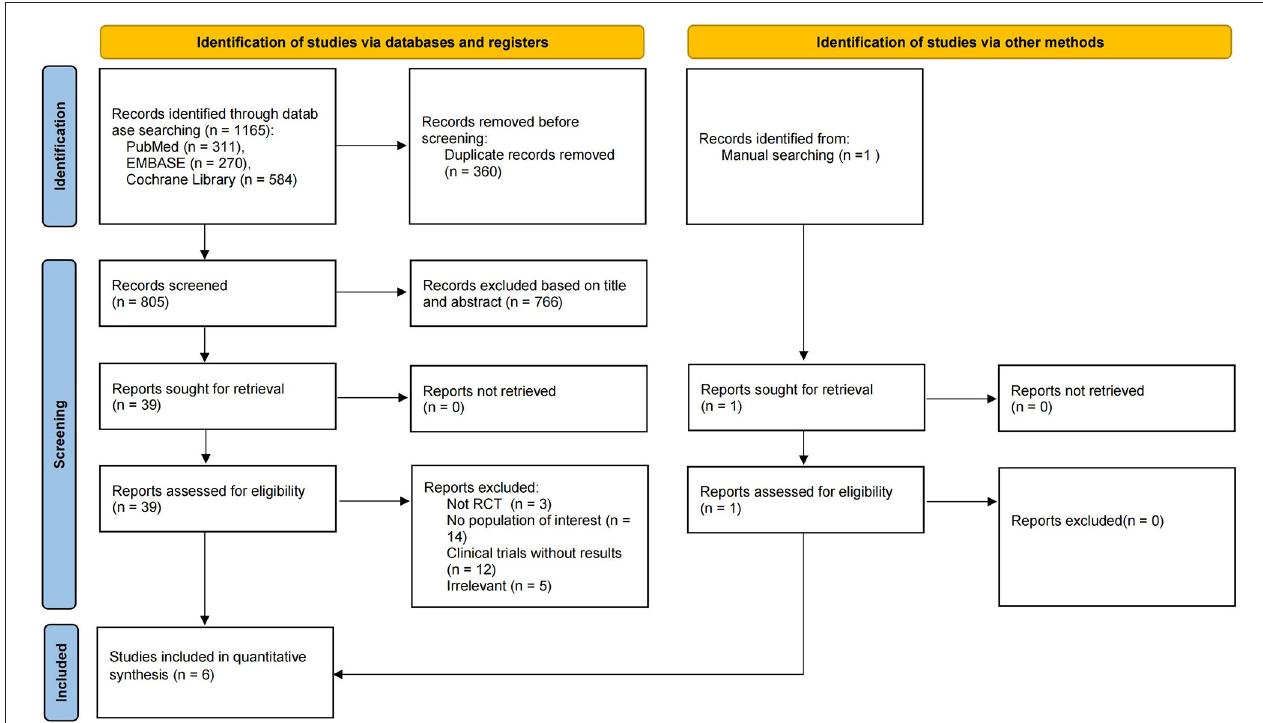
FIGURE 1 | Flow chart of study identification and